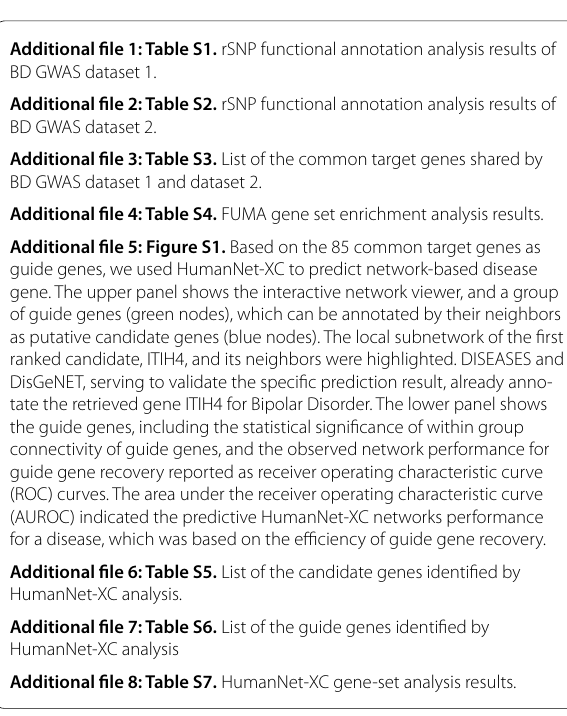
Additional file 7: Table S6. List of the guide genes identified by HumanNet-XC analysis Additional file 8: Table S7. HumanNet-XC gene-set analysis